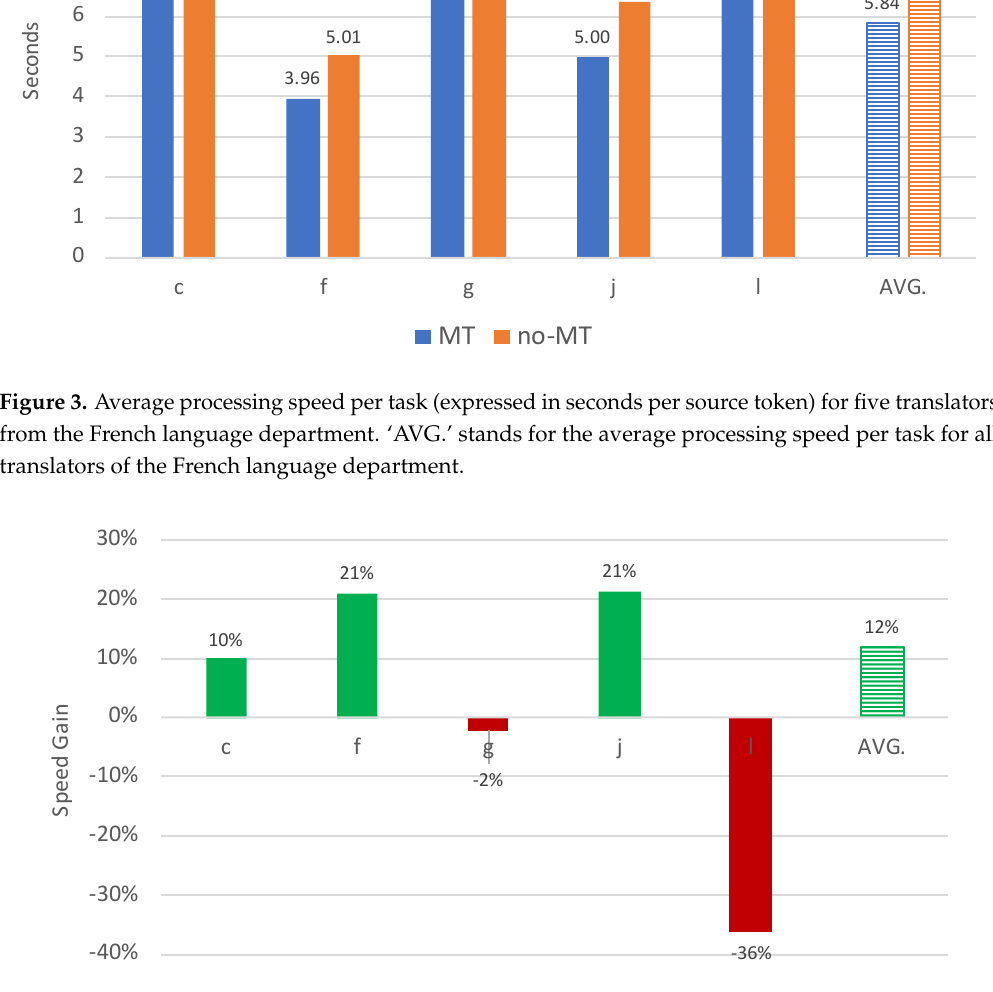
Figure 4. Relative speed gains when using MT, for five translators from the French language